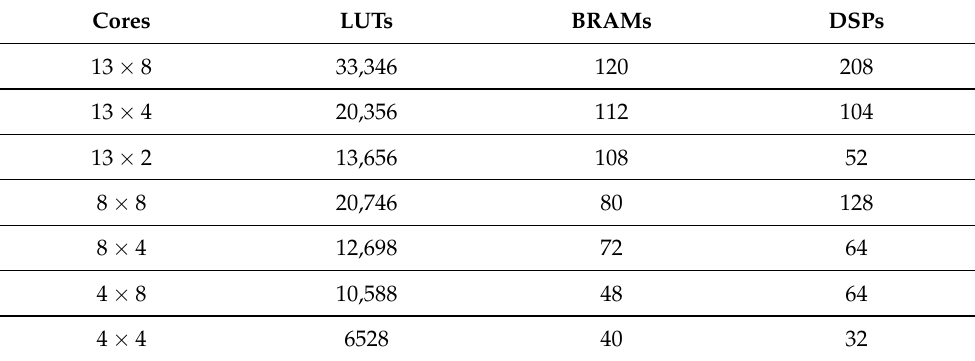
Table 5. Resource utilization of the accelerator for 8-bit datawidth, four MACs per core, and different numbers of cores.